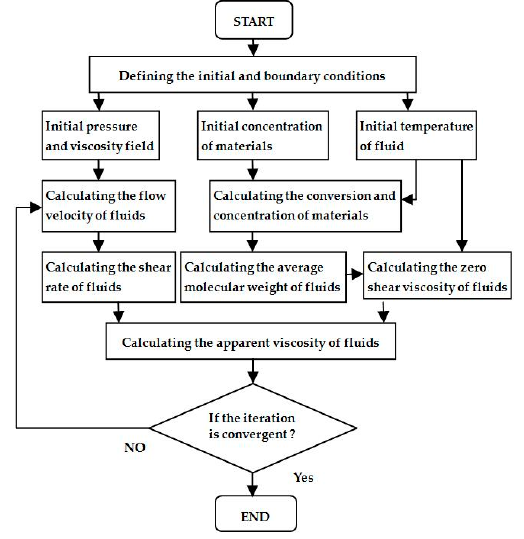
Figure 2. Flow chart of numerical simulation.